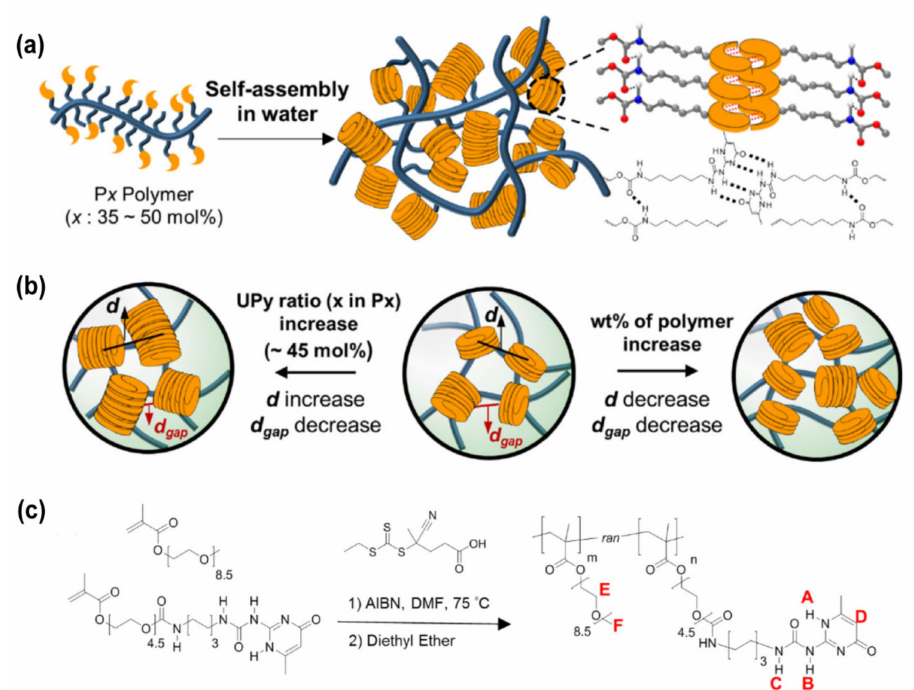
Figure 3. ( a ) A general view of the self-assembly of P(PEGMA-co-(PEGMA-UPy)) polymers in the aqueous solution. The yellow discs indicate the UPy-UPy dimer. ( b ) Schematic representation of the interdomain distance ( d ) and the characteristic gap distance ( d gap ) as a function of the UPy fractions and the polymer weight fraction in the hydrogel. ( c ) Schematic representation for the synthesis of P(PEGMA-co-PEGMA-UPy)) polymers. Reprinted with permission from Ref. [164]. Copyright 2021 American Chemical